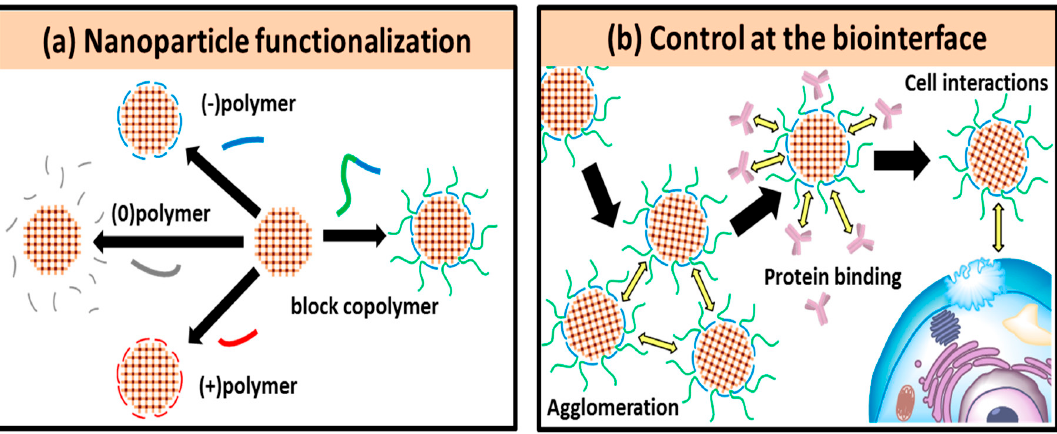
Figure 2. ( a ) Schematic illustrating the coating procedure for four different polymer groups; ( b ) Studies with functionalized MOF biointerfaces. Reproduced with permission from Ref. [36] Copyright 2019, American Chemical Society.